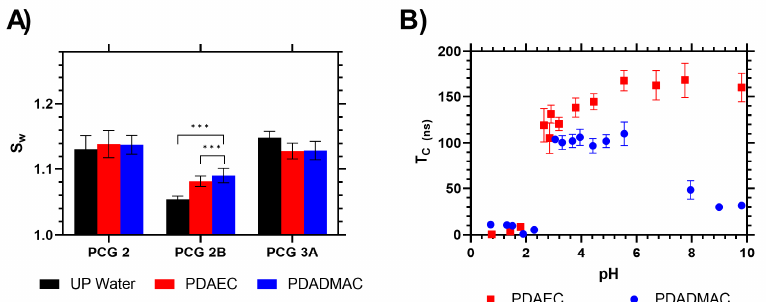
Figure 7. ( A ) Swelling of hydrogels in ultra-pure water and dilute (1 mg mL − 1 ) solutions of polymer flocculants. ( B ) pH dependence of electrostatic bonding of PAA with PDAEC (red diamonds) and PDADMAC (blue diamonds). *** indicates statistical significance of difference via a T test pairwise comparison.